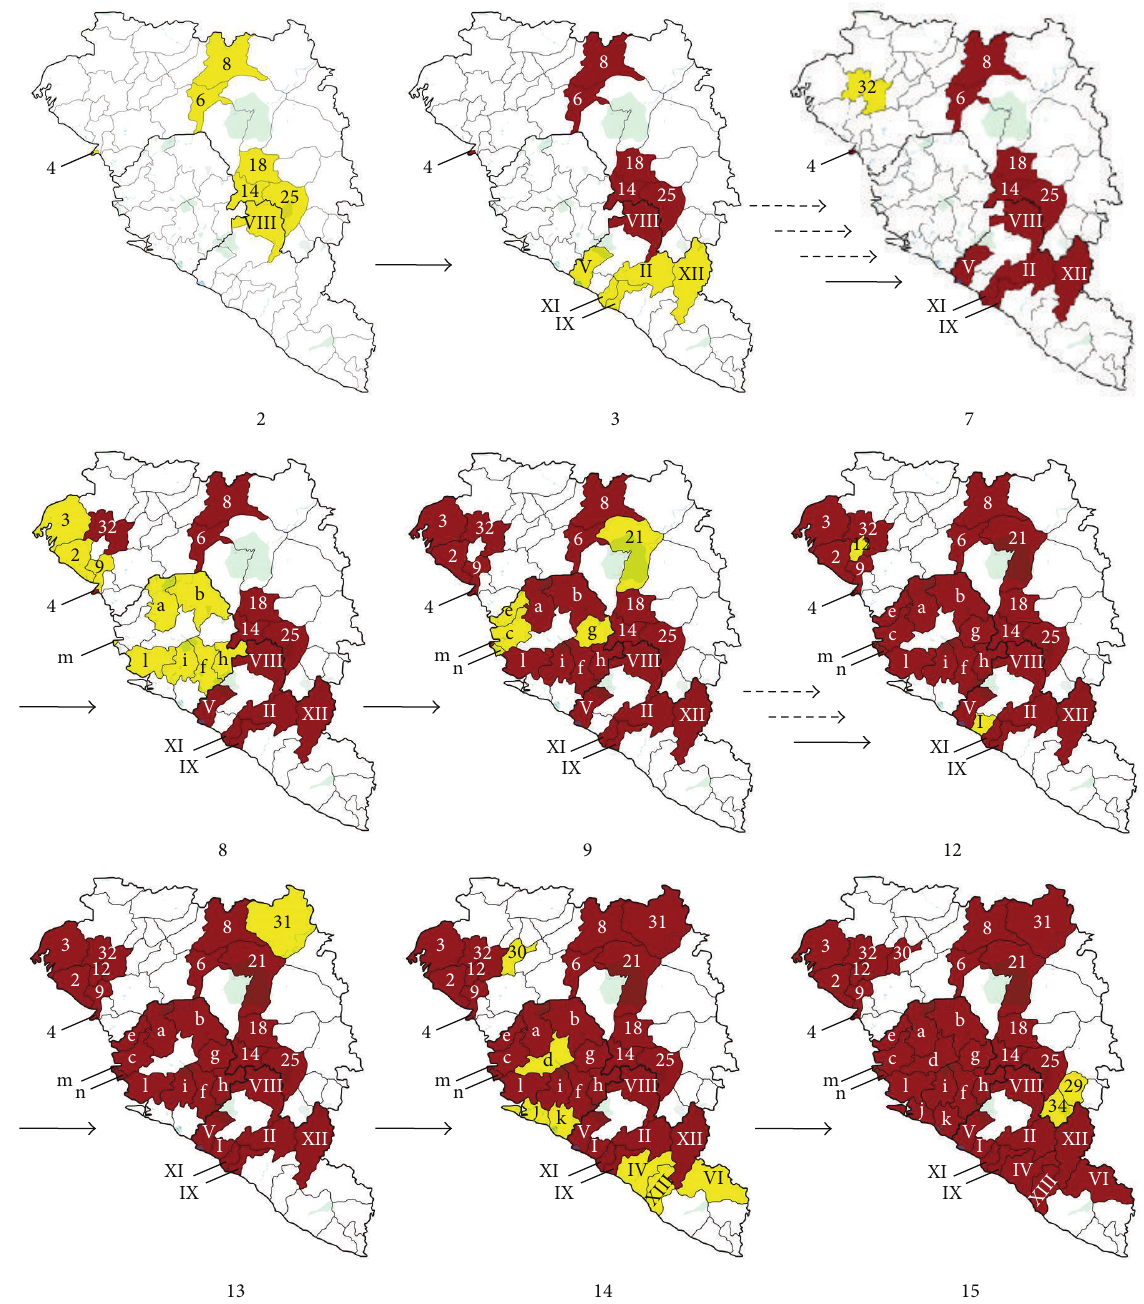
Figure 5: Progressive geographical spread of the EVD outbreak from period 2 to period 15 (for period 1, until the publication of the first WHO report, consolidated geographical details have not been identified). During periods 4, 5, and 6 and during the periods 10-11 there were no progressions in the geographical spread. The periods are reported according to Table 1. Areas barely affected by the epidemic are shown in yellow; the areas already interested with the progression of time are shown in red. Only areas progressively affected were numbered according to administrative areas reported in Figure 4. Solid arrow indicates a spreading into new areas during subsequent periods, according to Table 1. Intermittent arrow indicates no EVD diffusion in new areas for a number of periods according to the arrows